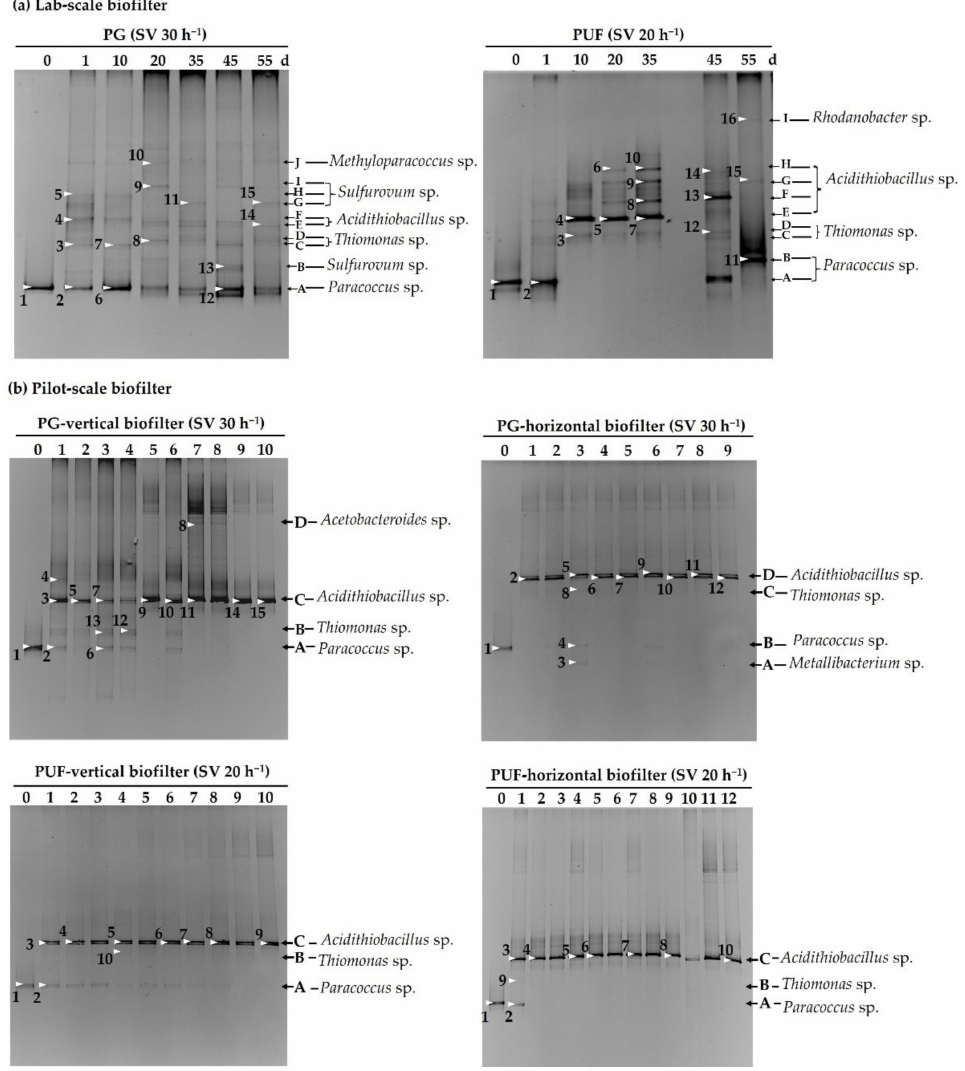
Figure 7. DGGE profiles of the bacteria present in the PG and PUF from laboratory-scale biofilters ( a ) and pilot-scale biofilters ( b ). The numbers on the results are from different samples collected at the end of the operation. Please note that the laboratory-scale biofiltration was carried out for 60 days; however, the DNA extraction was not successful on day 60 due to an accumulation of sulfate